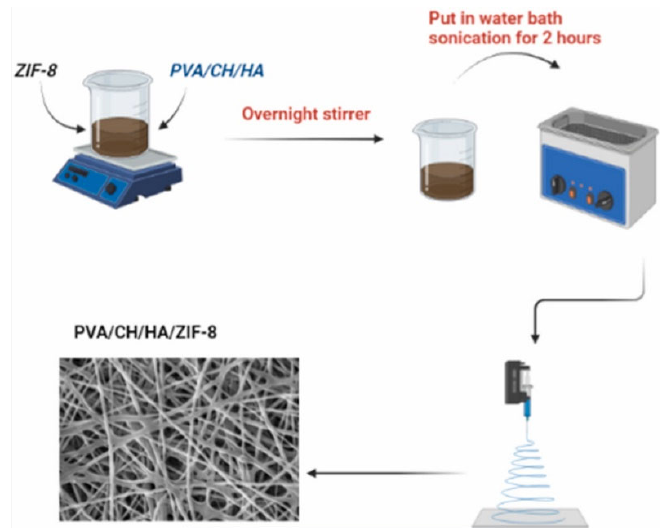
Figure 21. Scheme showing synthesis of ZIF-8@PVA/CH/HA composite. The synthesis of composites is done by stirring the ZIF-8 in PVA/CH/HA suspension overnight, then sonicating it for 2 h followed by electrospinning to yield fibres of ZIF-8@PVA/CH/HA. Reproduced with permission from [178] .